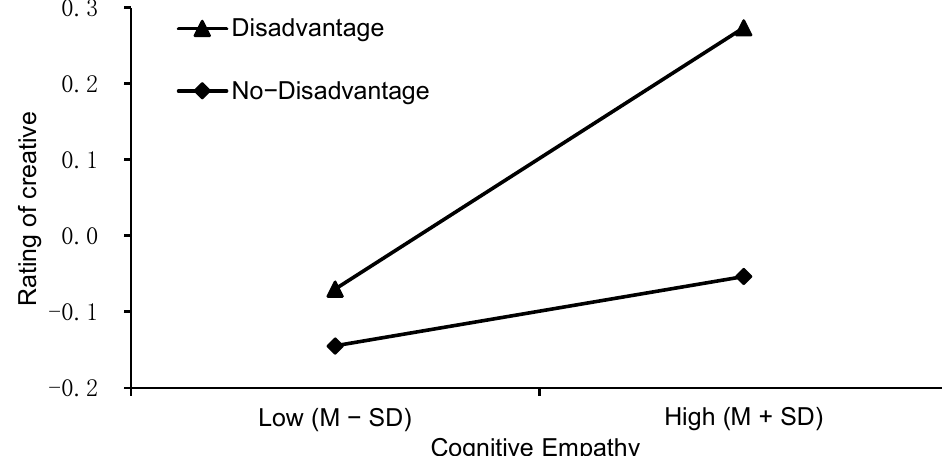
Figure 2. The interaction effect of cognitive empathy and the creator’s situation on creative evalua- tion.